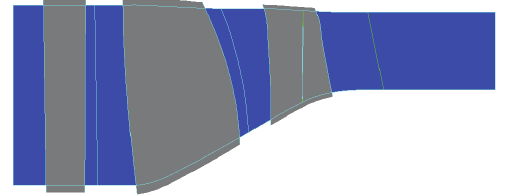
F 2: AutoGrid meridional view (blades extruded beyond endwalls to ensure robust grid generation).